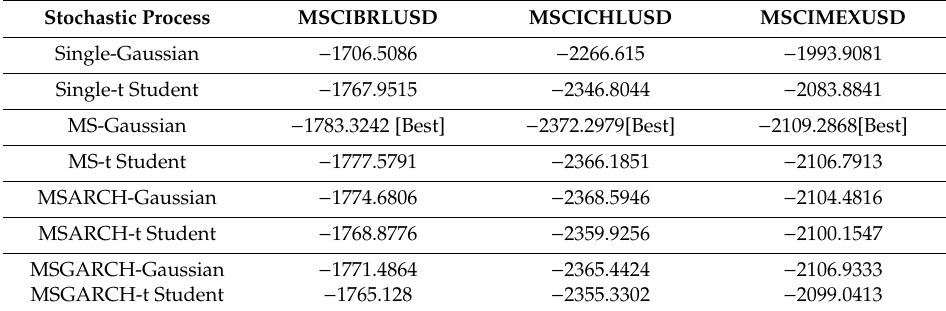
Table 4. Summary of the weekly recursive fitting analysis of the di ff erent MS models tested in each